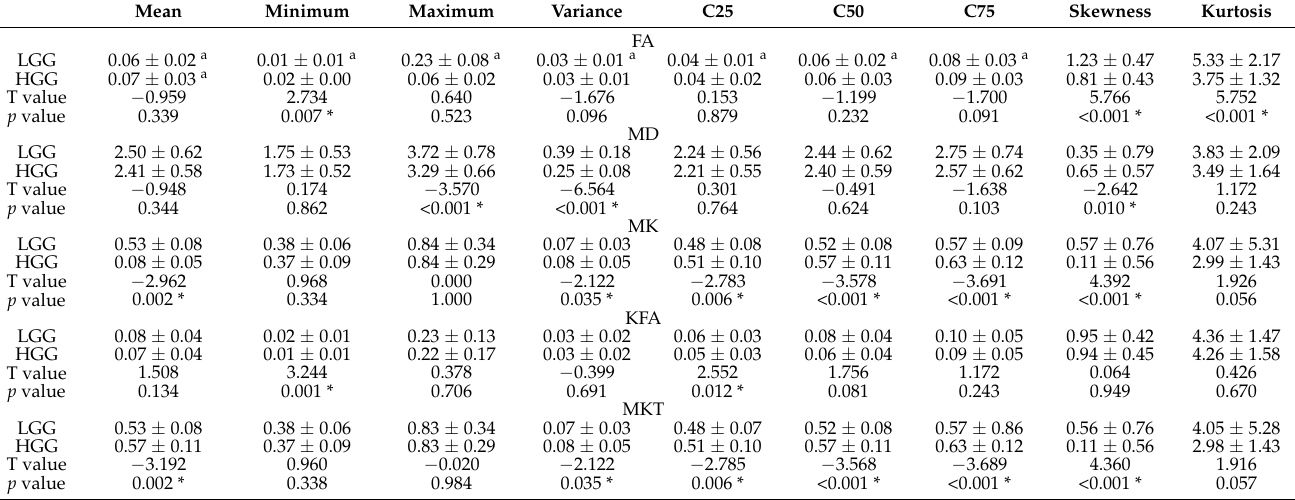
Table 2. The comparisons of DKI histogram parameters between low-grade glioma (LGG) and high-grade glioma